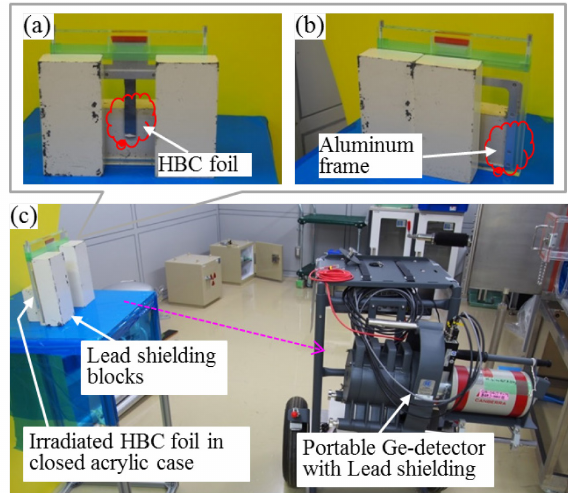
Fig. 8. Experimental setup for activation analysis of collected foil by using portable Ge semi-conductor detector.